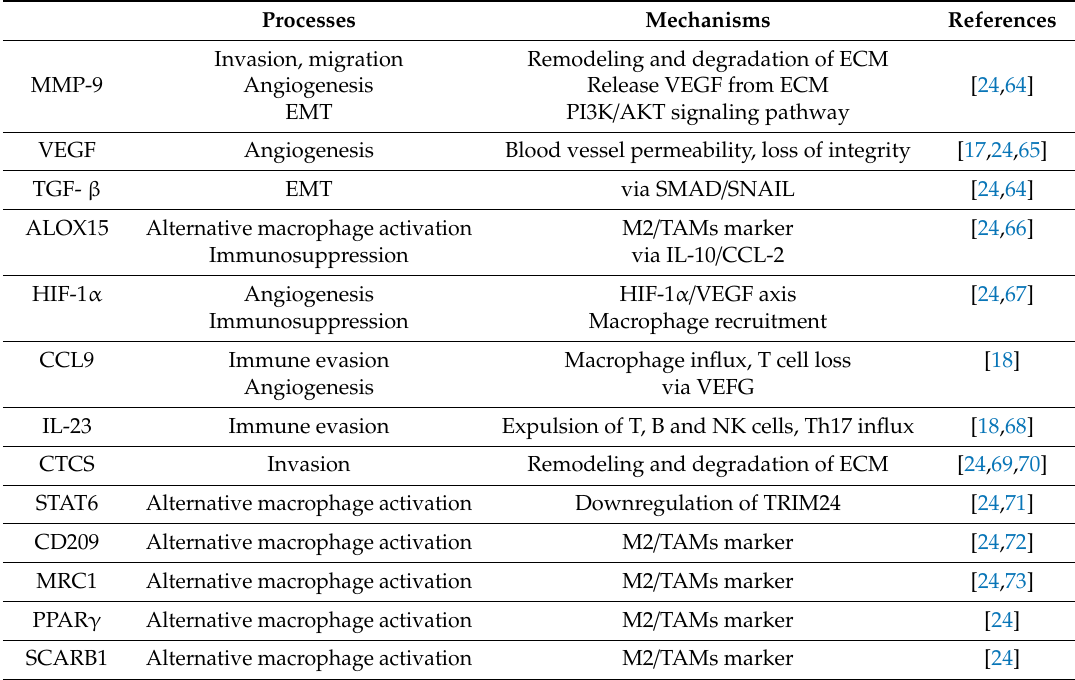
Table 1. Cytokines, chemokines, enzymes and signaling molecules up-regulated by MYC in tumor-associated macrophages (TAMs) and their role in cancer aggressiveness and